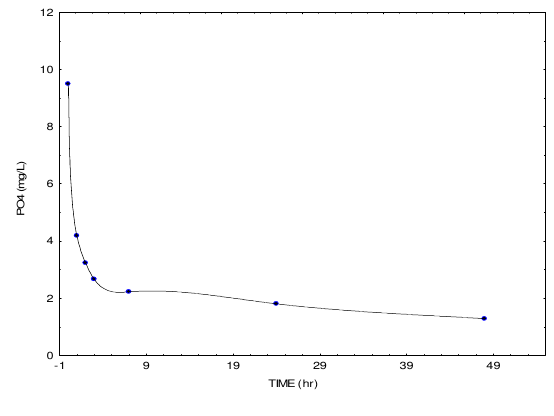
Fig. 4. PO 4 Pollutant concentration with time at T = 25 o C, pH 7, wastewater/(Algae broth) ratio = 1, and sterilized wastewater.